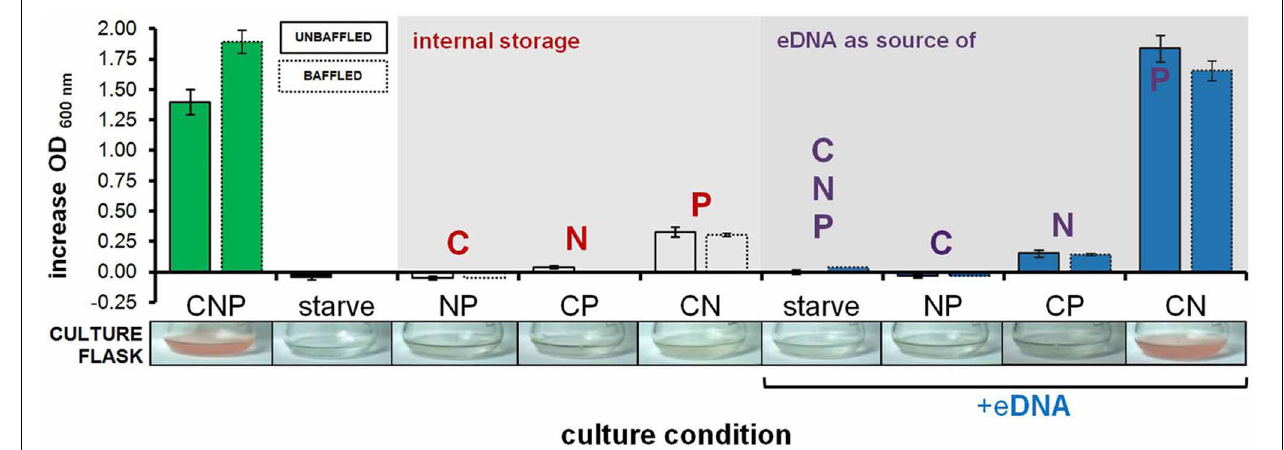
FIGURE 2 | Growth on eDNA as a C, N and P source in culture flasks. H. volcanii cultures were grown in Hv-min derivatives deficient in C, N, or P (NP, CP, CN, respectively) with and without eDNA supplementation. Bars represent increase in optical density after 60h of incubation in unbaffled